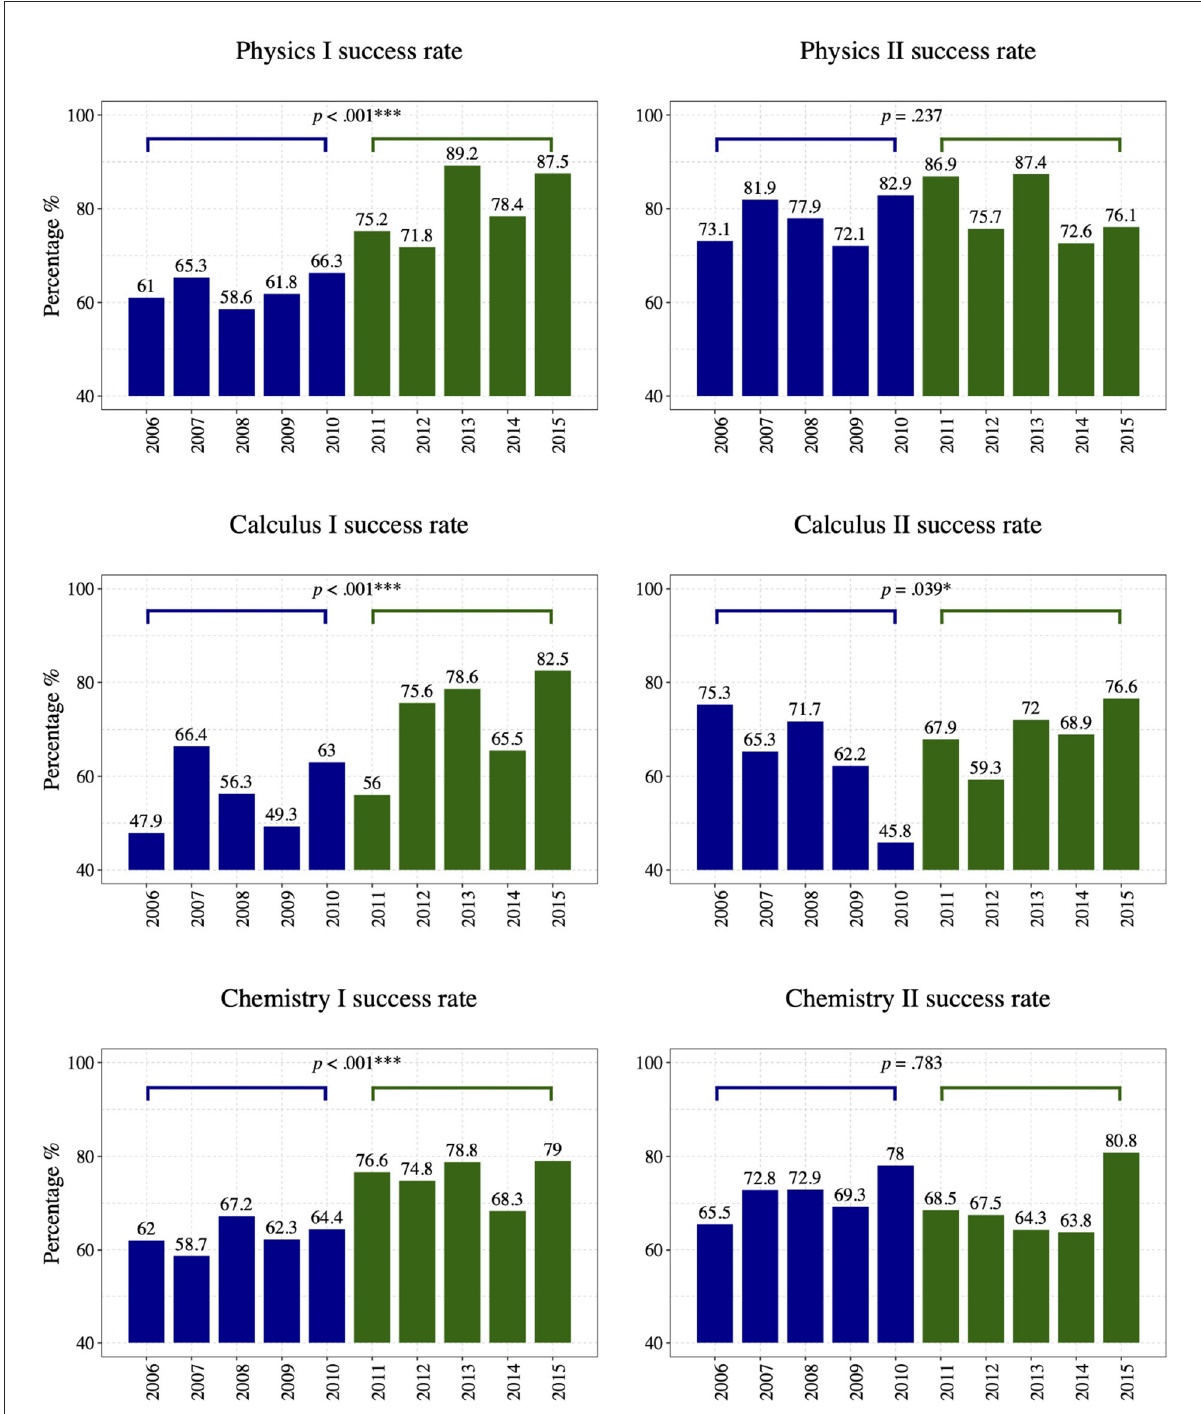
FIGURE5 The success rates of High-Risk engineering students in the early STEM courses from the cohort years Fall 2006–2015. The success rates in the pre-intervention years (Fall 2006–2010) are shown in blue, whereas the post-intervention years (Fall 2011–2015) are in green. The significance levels and the p -values indicating the differences in the pre-intervention and intervention years are shown in the individual graphs. ∗∗∗ p < 0.001, < 0.01, and < ∗∗ p ∗ p